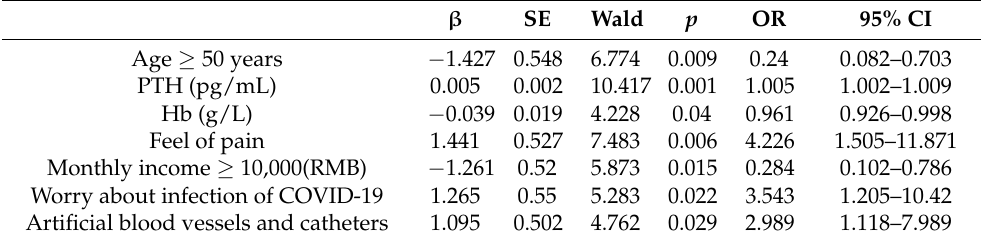
Table A2. Logistic analysis of risk factors of anxiety in the MHD patients.